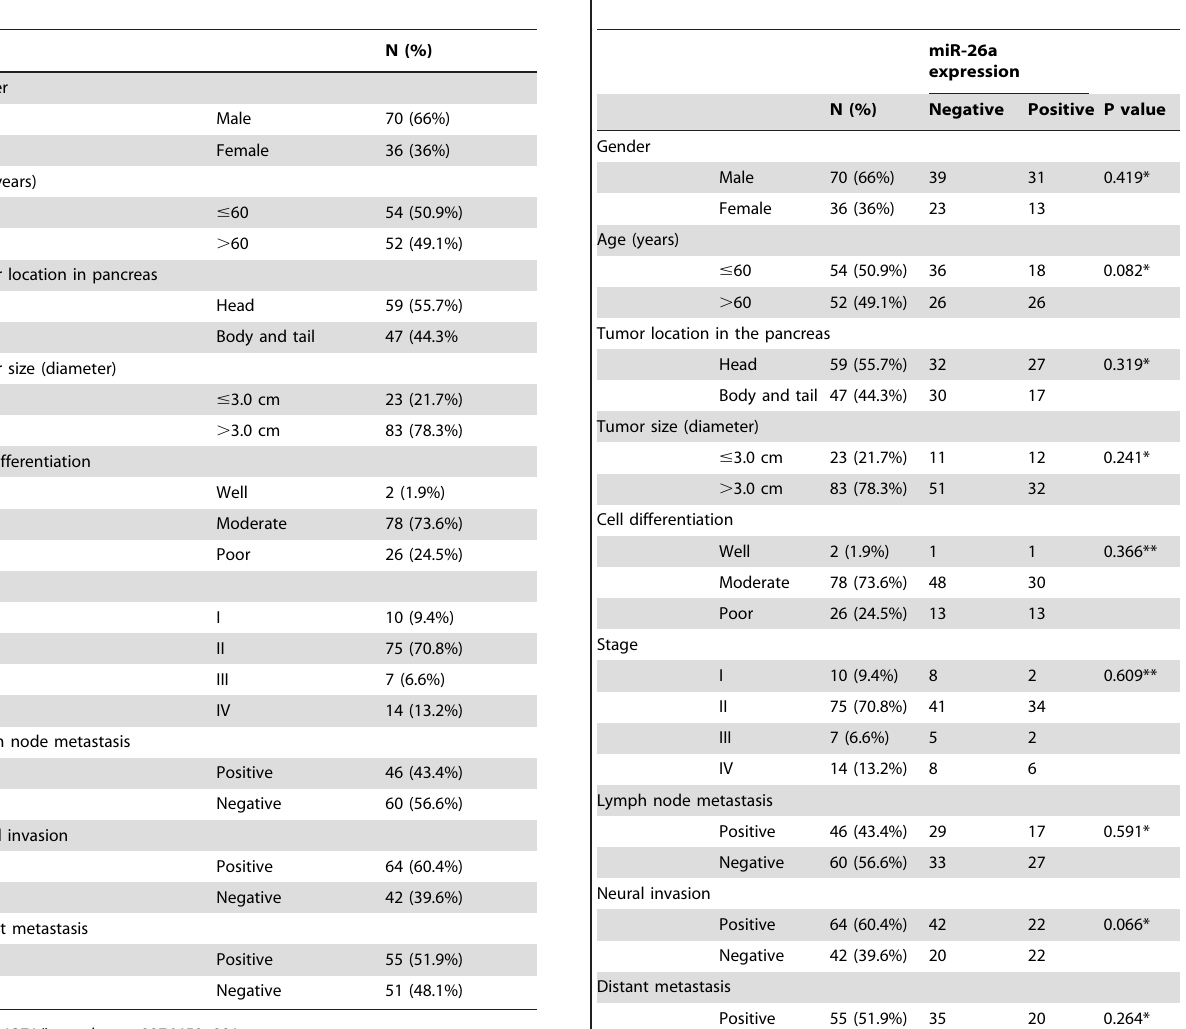
Table 1. Clinicopathological characteristics of 106 cases of pancreatic cancer.